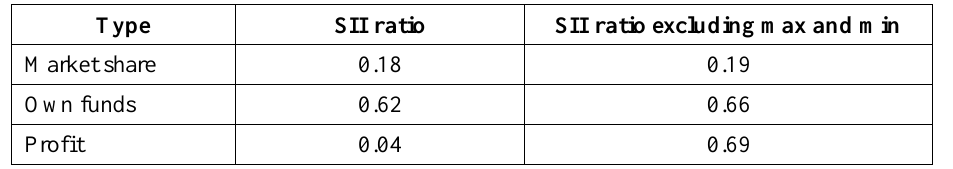
Table 2. Pearson correlation analysis of solvency